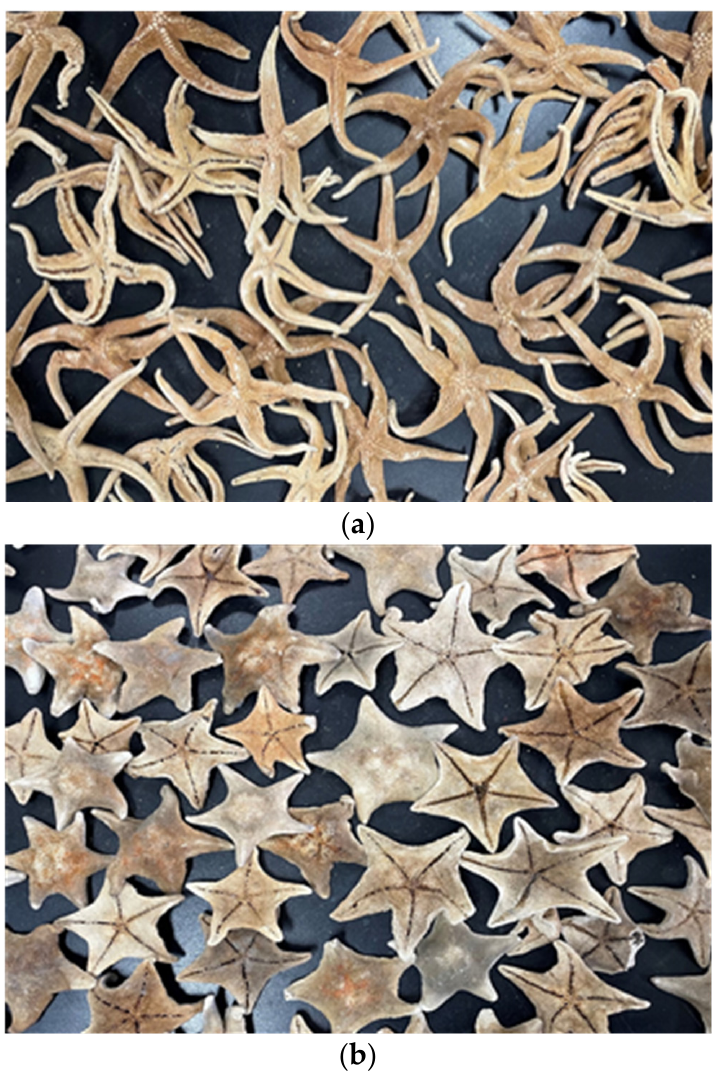
Figure 1. Pictures of ASF ( a ) and PSF ( b ). Table 3. Treatability matrix for Hg contaminated